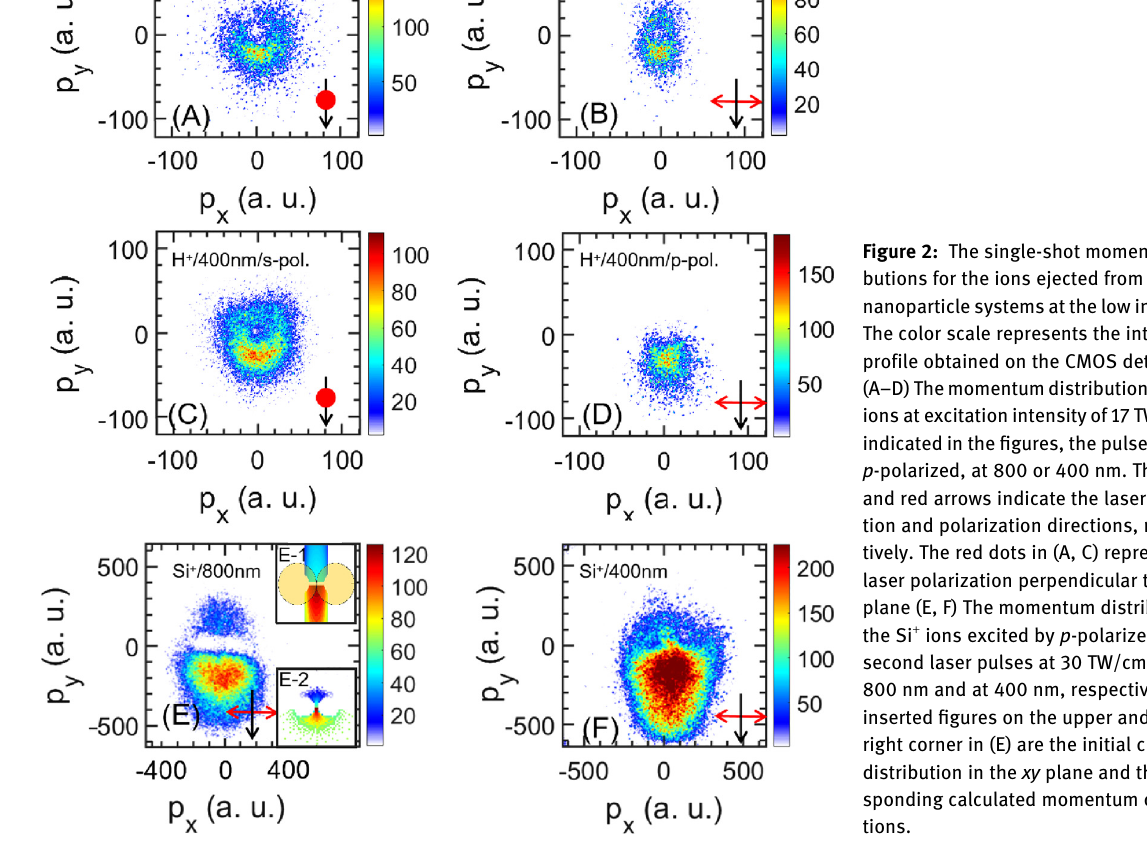
inserted fi gure in Figure 2(E-1), the initial charge density